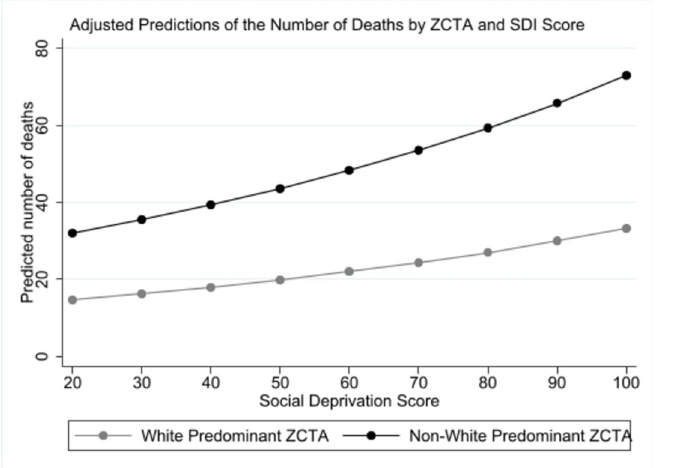
Fig 1. Predicted number of deaths compared with SDI